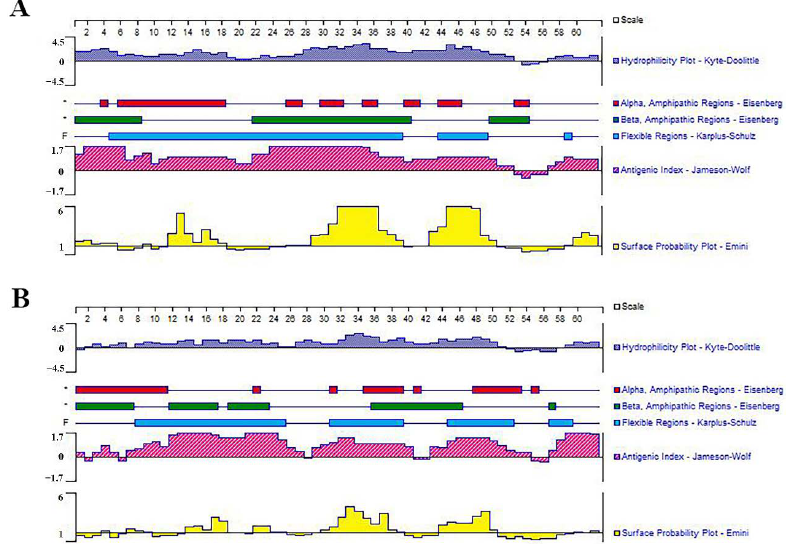
Figure 3. Prediction of hydrophilicity, antigenicity and surface probability of multi-epitope tandem. ( A ) MEPIP; ( B ) MEPIG.